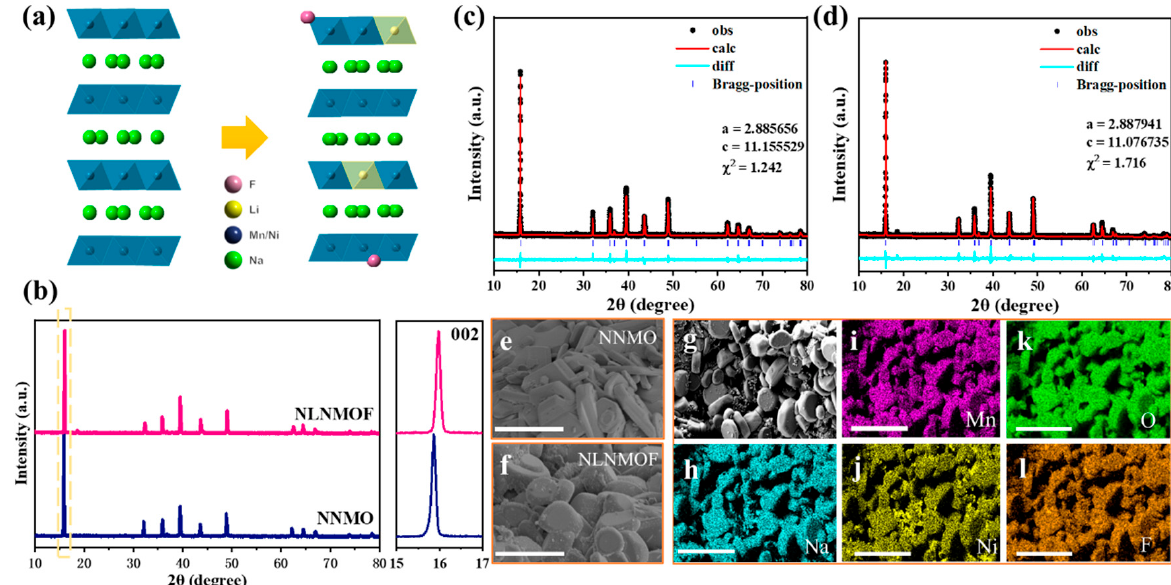
Figure 1. ( a ) Schematic illustration of the crystal structures of NNMO and NLNMOF. ( b ) XRD patterns of NNMO and NLNMOF with the (002) peaks enlarged on the right. Rietveld refinement results of ( c ) NNMO and ( d ) NLNMOF. SEM images of ( e ) NNMO and ( f ) NLNMOF, with the corresponding EDX maps for NLNMOF displayed in ( g – l ). Scale bars: 5 μ m in ( e – f ) and 10 μ m in ( g – l ).